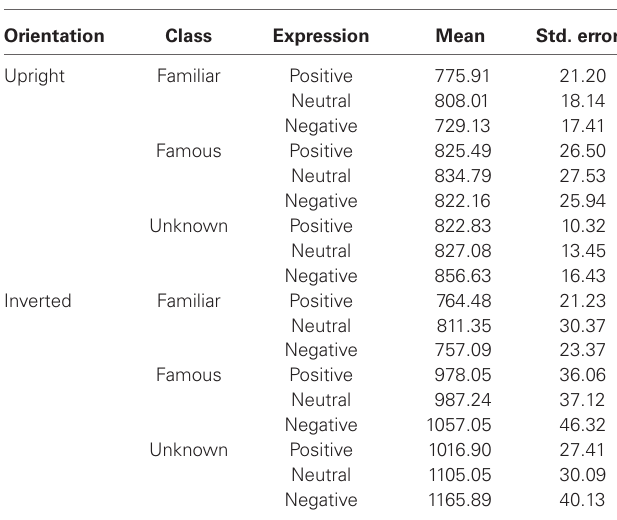
Table 1 | Means and standard error for reaction